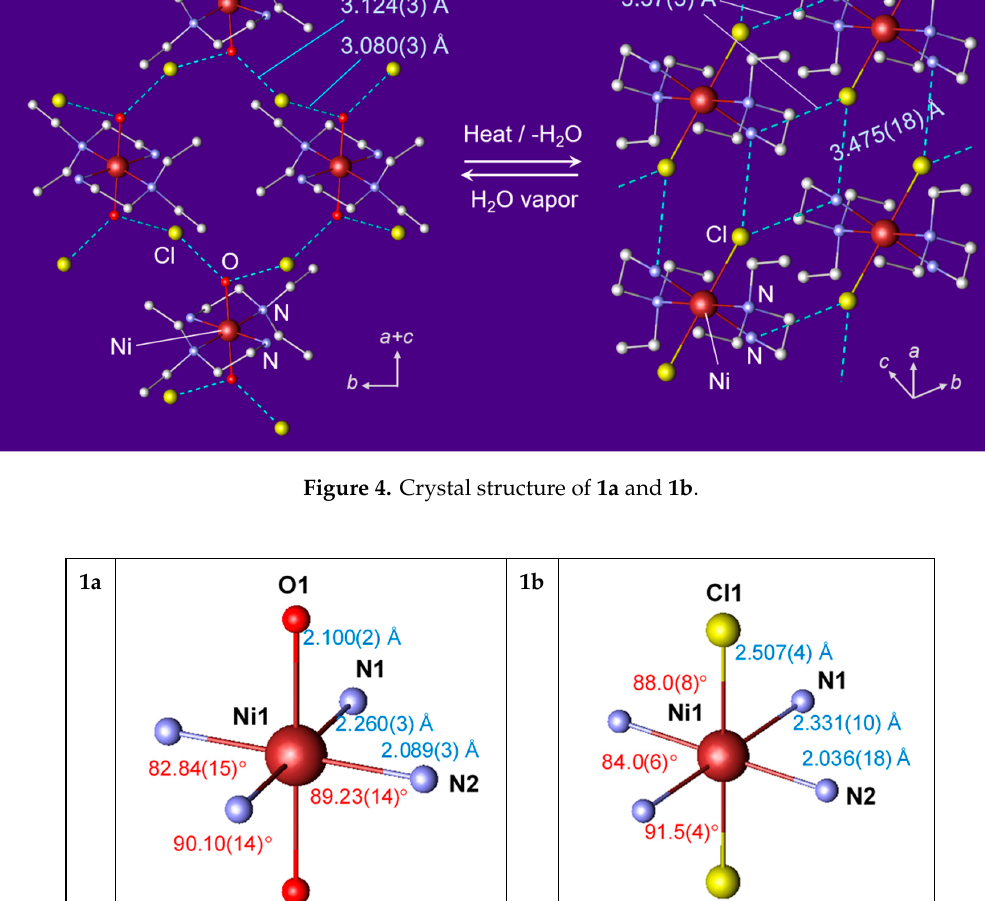
Figure 5. Distances and angles of bonds around the Ni(ii) ion of 1a and 1b .